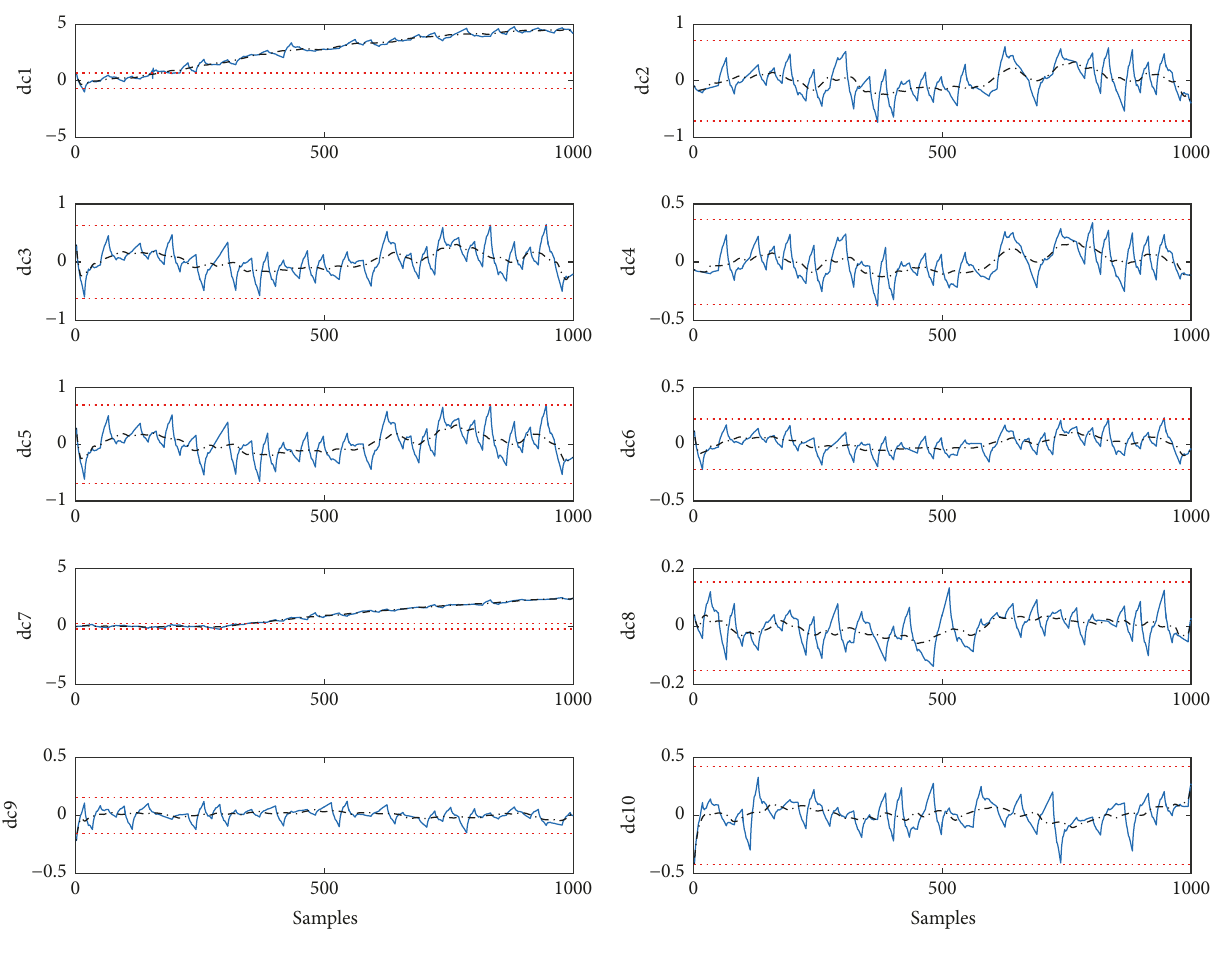
Figure 4: WF-DCA-based early faults diagnosis.